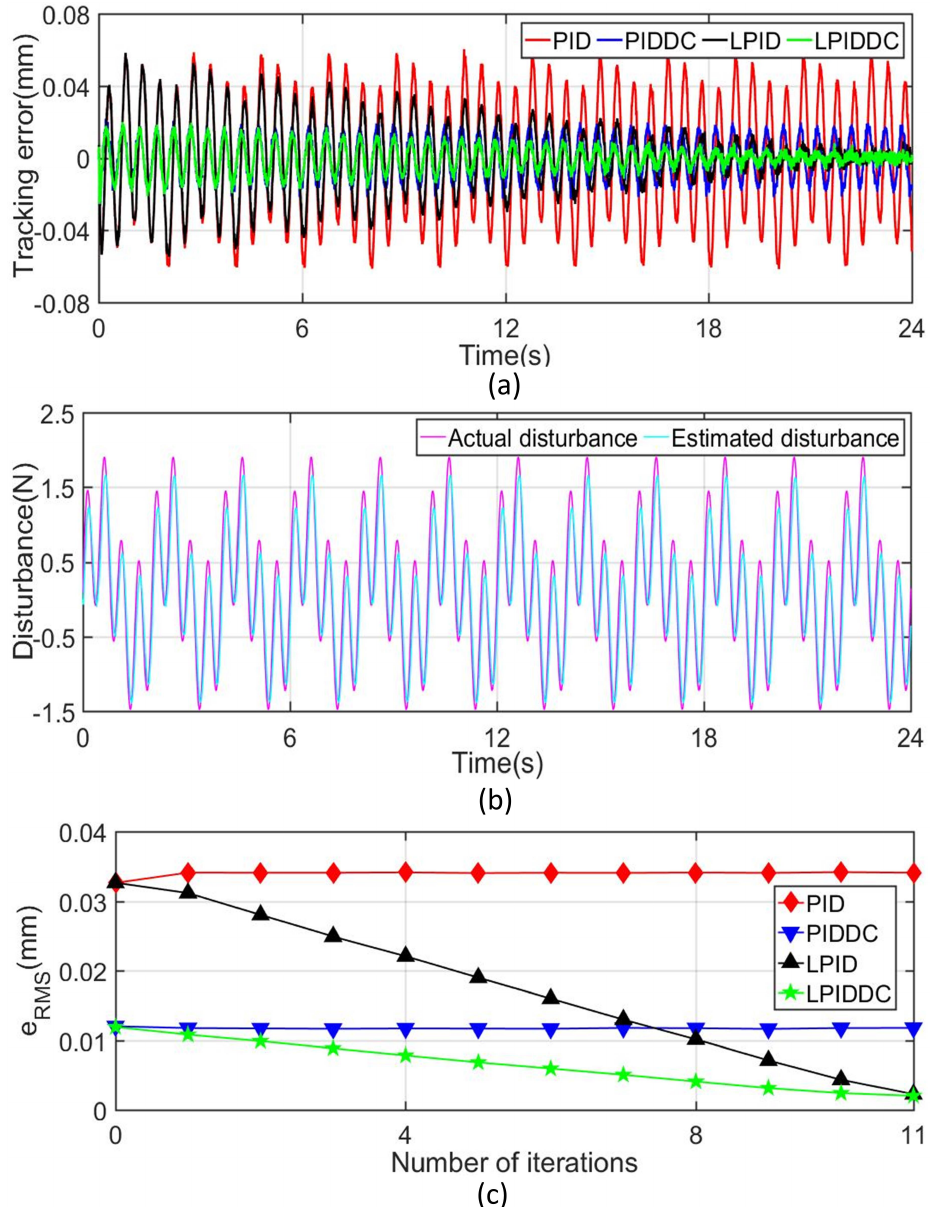
Figure 6. Tracking results of Track1 with complex disturbance. ( a ) Tracking error in s z -axis. ( b ) Disturbance quantity and its estimated value. ( c ) Convergence rate of e RMS in s z